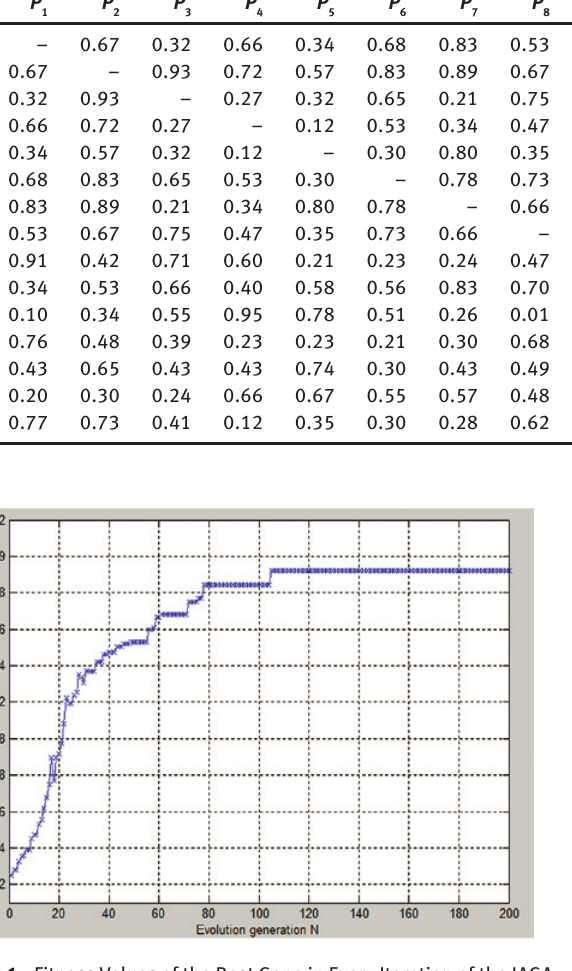
Figure 1: Fitness Values of the Best Gene in Every Iteration of the IAGA.